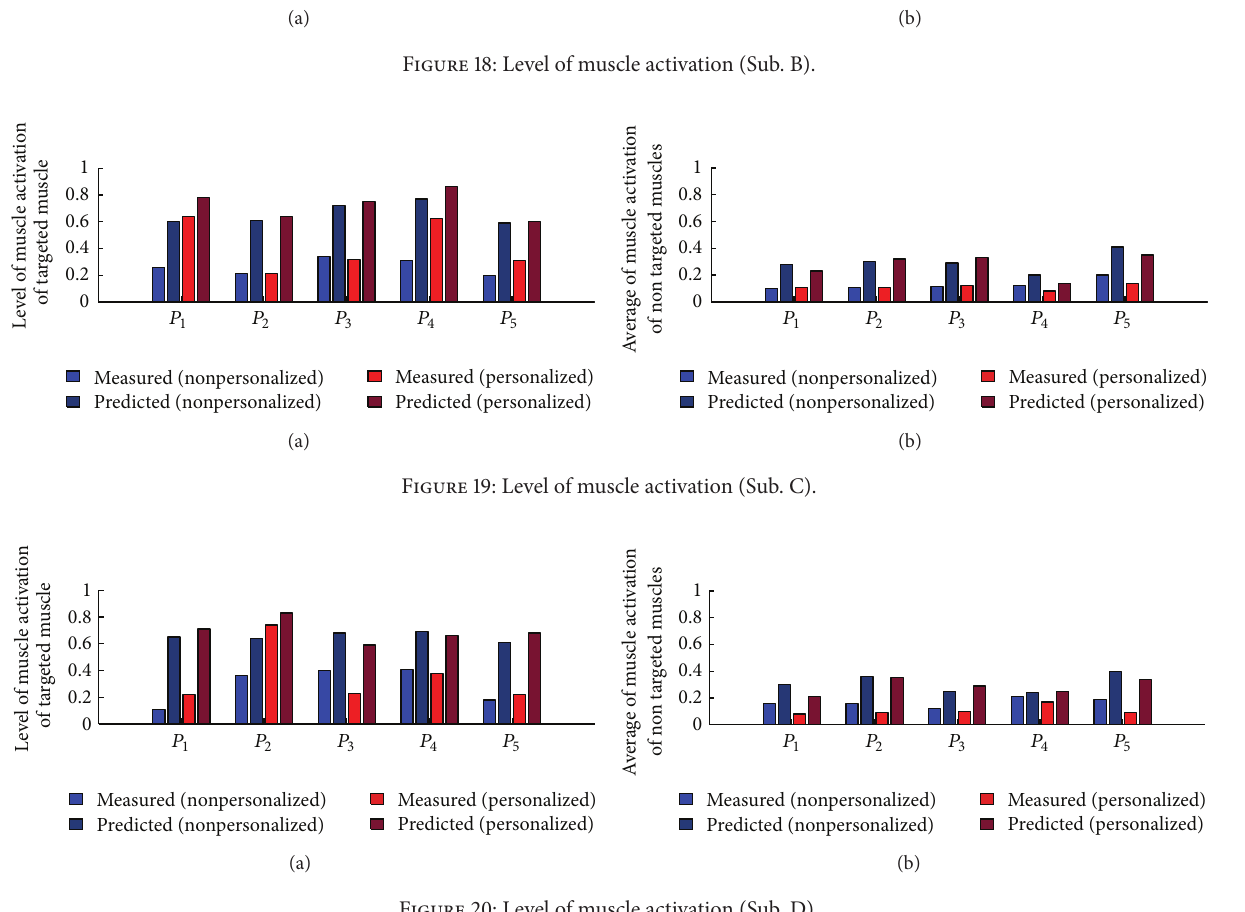
Figure 20: Level of muscle activation (Sub.